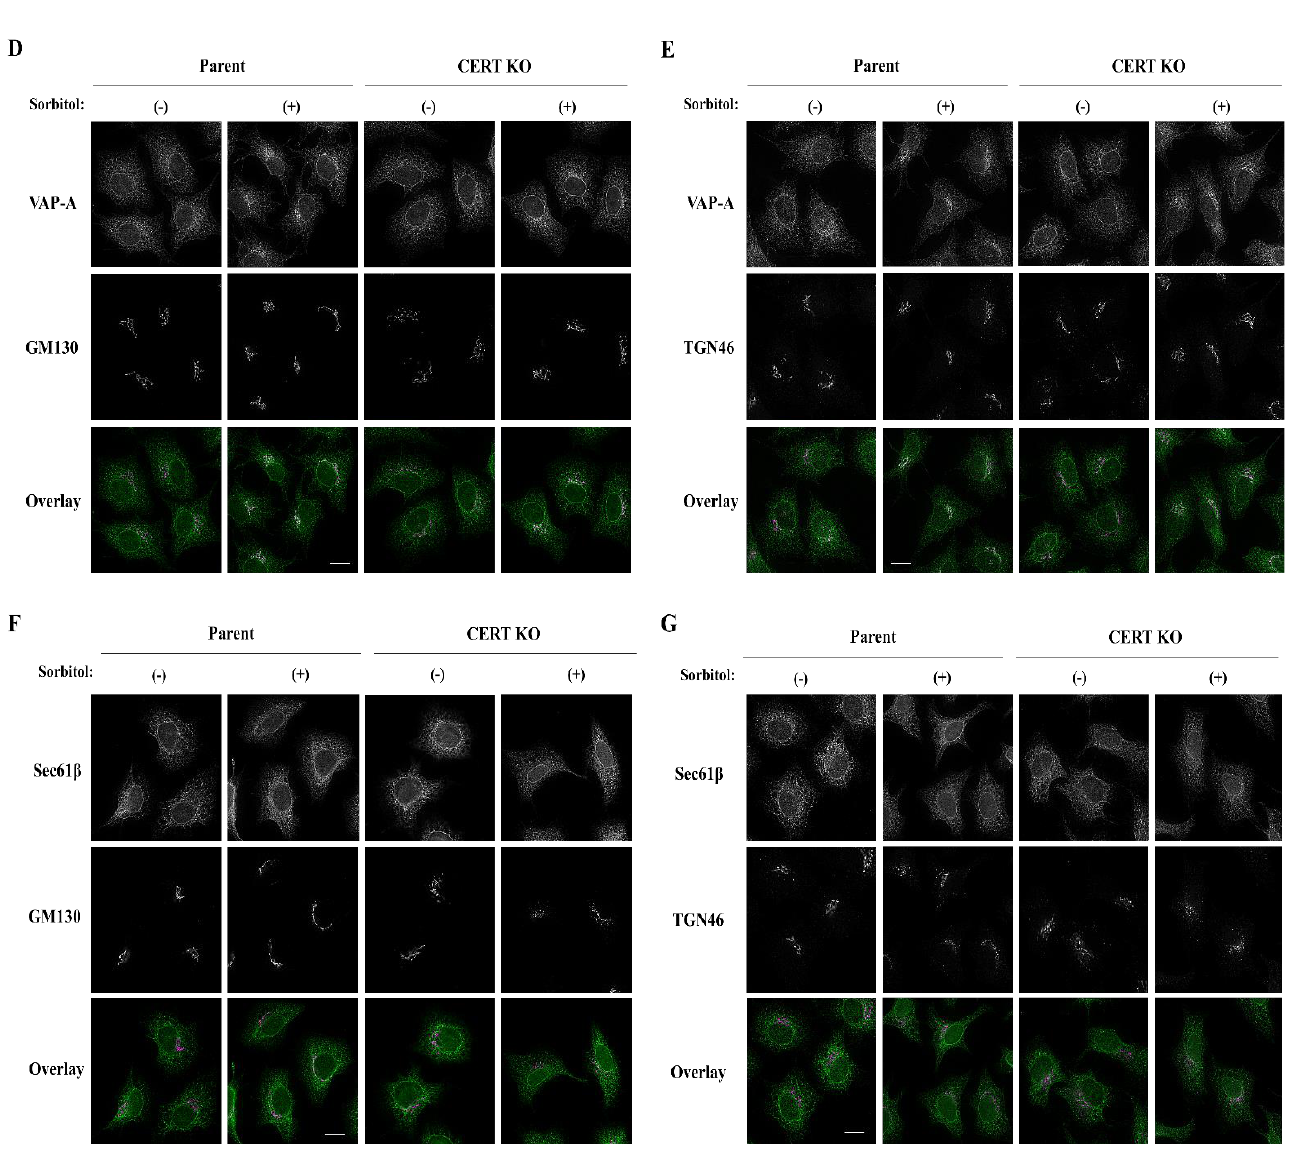
Figure 3. The hyperosmotic stress-induced CERT S315 phosphorylation augments the binding to VAP-A. ( A ) The cell lines ectopically expressing each mVenus-CERT mutant were established from CERT KO cells as parents. The lysates were immunoblotted with the respective antibody (CERT, GFP, and GAPDH) or the antiserum against CERT ( C -terminus epitope). ( B ) The enhanced binding to VAP-A occurs in the S315 phosphorylation-dependent manner. An increase in co-immunoprecipitated VAP-A with CERT WT occurs along with the S315 phosphorylation, but the increased binding to VAP-A in cells expressing CERT S315A is not observed. Cells expressing each mVenus-CERT variant were treated with 800 mM sorbitol for 1 h. Then, cells were treated with 2 mM crosslinker DSP on ice for 30 min. The lysates were subjected to immunoprecipitation with GFP-agarose. The eluates or the lysates were immunoblotted with the respective antibody against S315p CERT, VAP-A, CERT, and GAPDH. Two independent experiments were performed, and similar results were obtained. ( C ) The physical proximity between CERT and VAP-A under hyperosmotic conditions. Cells expressing each mVenus-CERT variant were treated with 800 mM sorbitol for 1 h and subjected to the proximity ligation assay (PLA). The representative fluorescence micrographs (in overlay image, green: mVenus-CERT, magenta: PLA signals) are shown. The number of PLA dot signals per cells was counted using Fiji/ImageJ software (NIH) for the indicated number of cells. The box plot demonstrates the number of PLA signals per cells under the respective condition in a representative experiment. The line